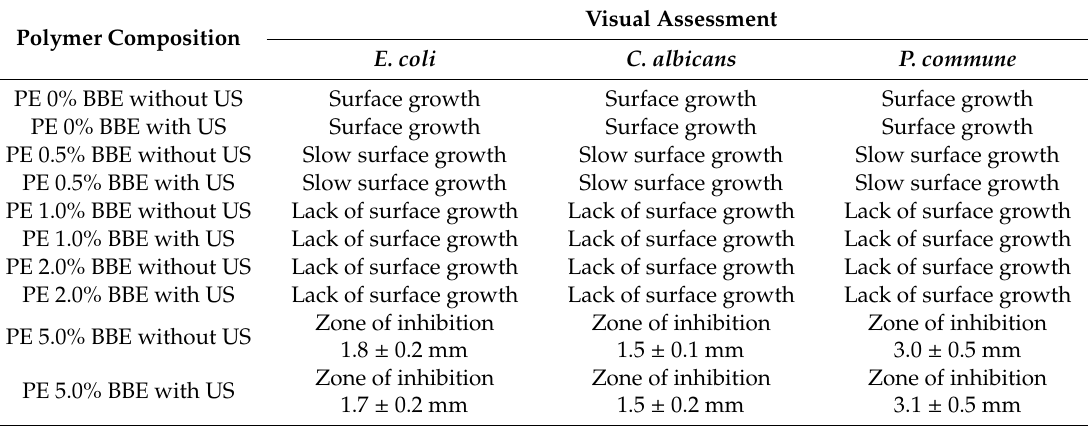
Table 5. Results of the visual assessment of the surface of polymeric materials based on polyethylene (PE) with birch bark extract (BBE) received with (with US) and without the use of ultrasonic (without US) treatment, inoculated for 24–48 h.